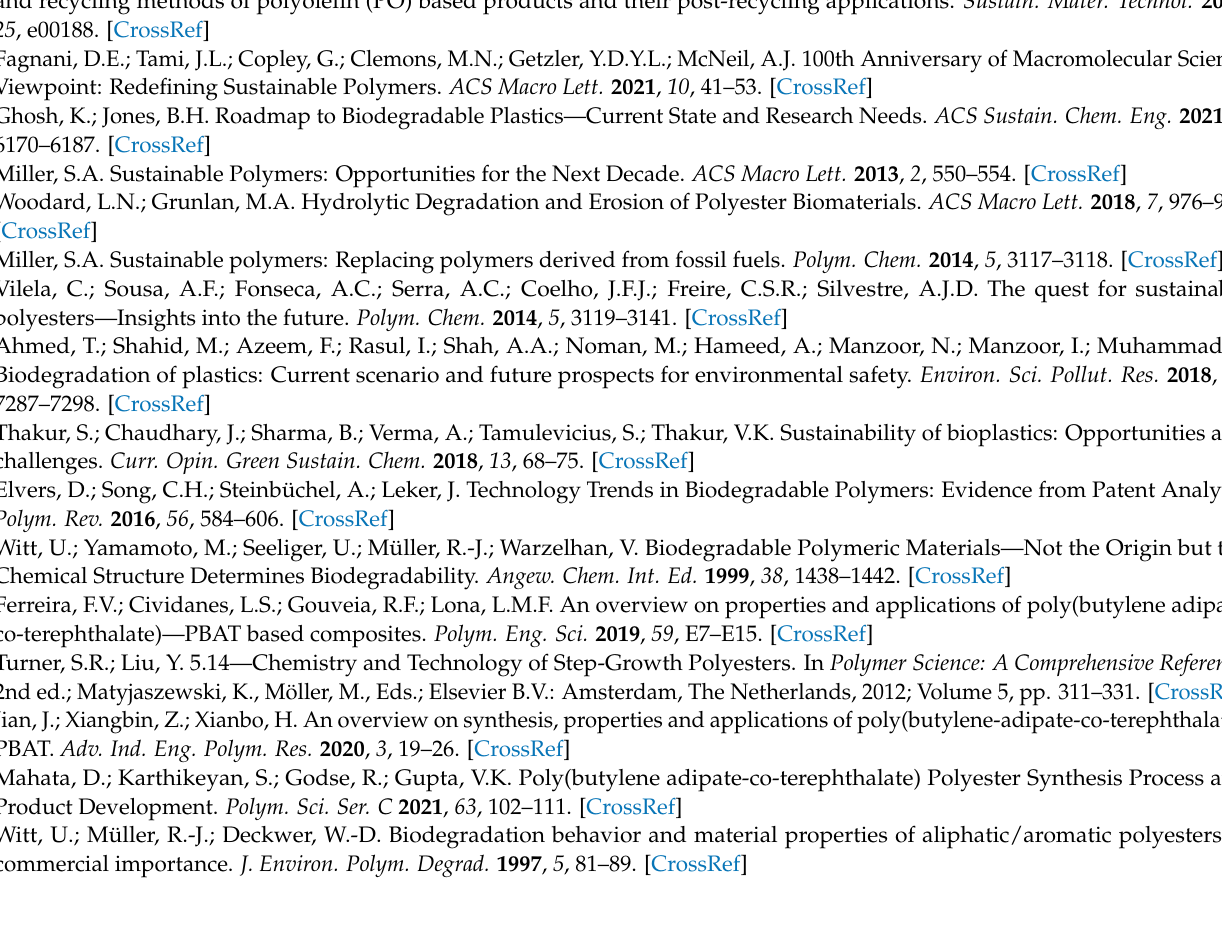
Figure S32: Frequency dependences of the storage and loss moduli at 130 (left) and 190 ◦ C (right). The polymer numbers are presented in the legends. References [50,56,62,70–75] are cited in the Supplementary